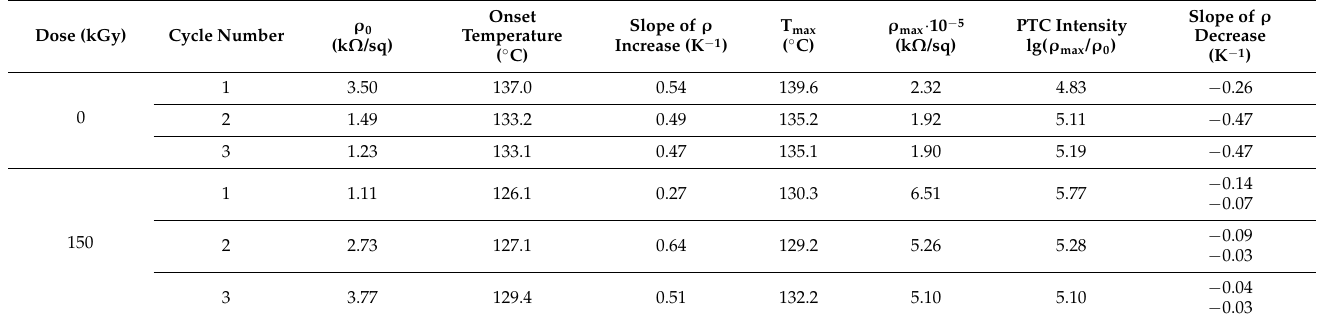
Table 2. Kinetic data of resistivity increase upon the heating of (CB + Gr)/HD composites.